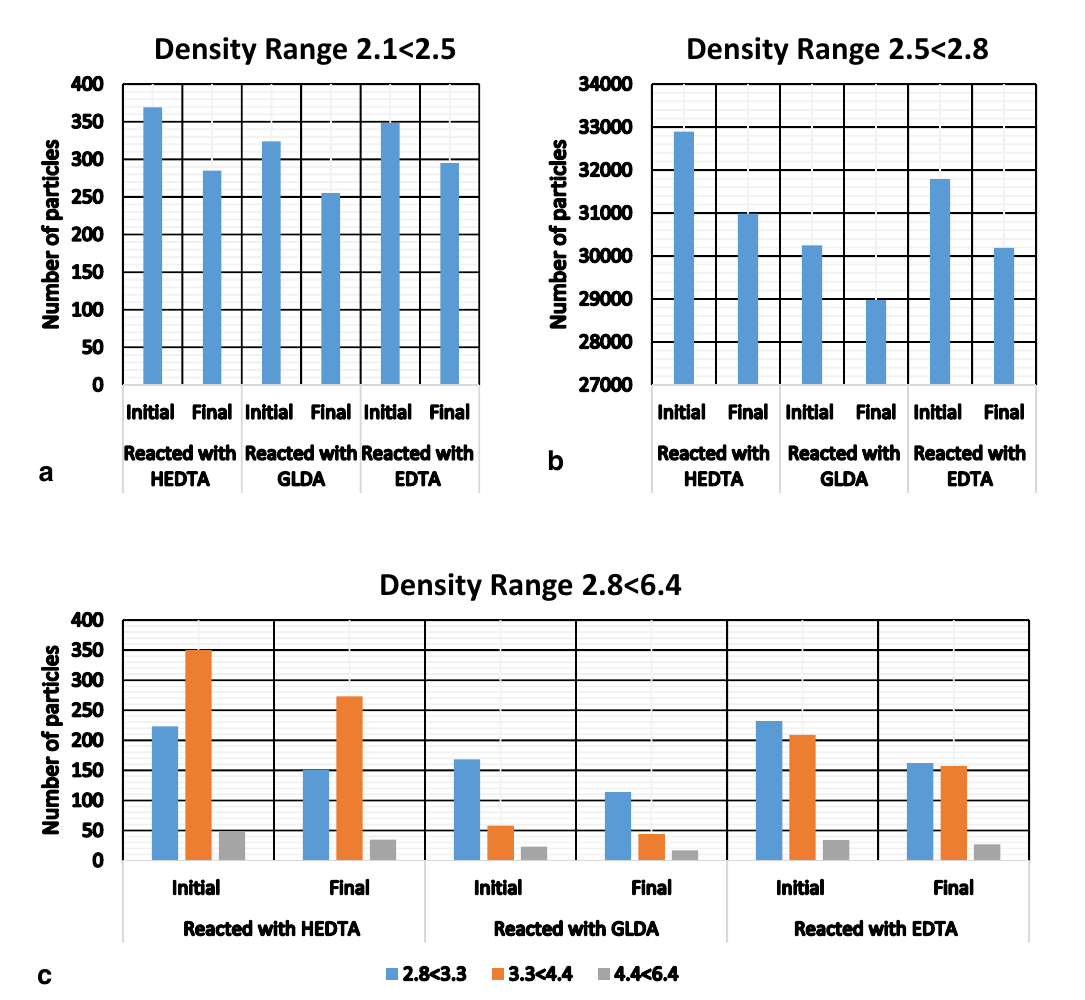
Fig. 18 Particle density distribution in Berea Sandstone before and after reaction with chelating